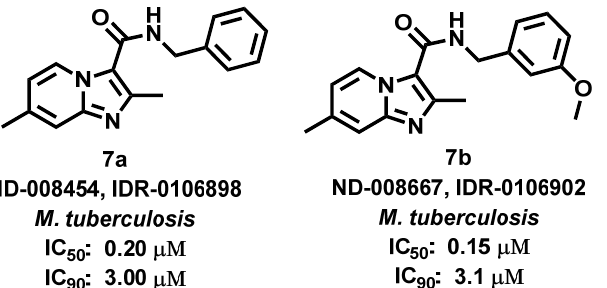
Figure 8. Imidazopyridine derivatives showing activity M. tuberculosis. Signatures of compounds according to Malley et al., 2018 [62].